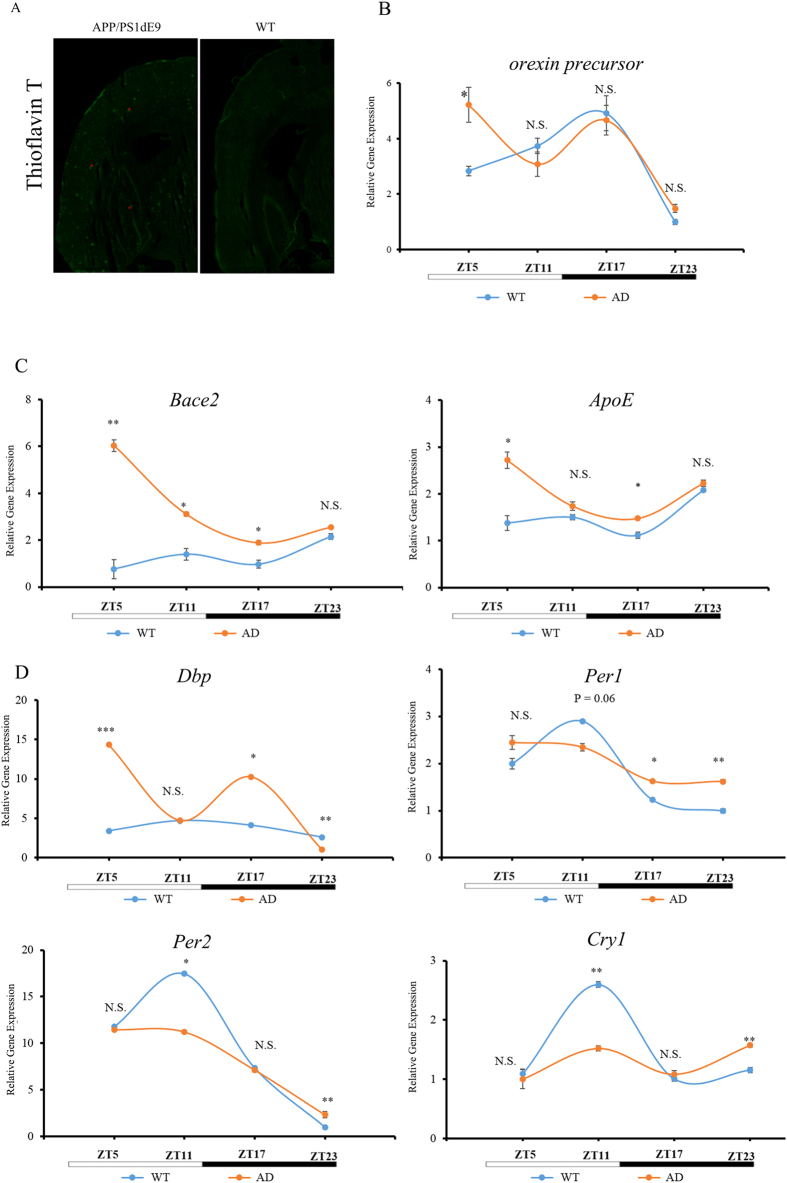
The rhythmicity of Bace2 and ApoE expression is altered in the hippocampus of APP/PS1dE9 mice.(A) Thioflavin T staining of WT and APP/PS1dE9 mice. Fibrillary amyloid plaques existed only in the brains of the APP/PS1dE9 mice (Red asterisks indicate fibrillary amyloid plaques). (B) The diurnal expression pattern of the orexin precursor gene is altered in the hypothalamus of APP/PS1dE9 mice. Expression of orexin precursor mRNA was analyzed by qPCR in the hypothalamus of WT and APP/PS1dE9 mice. The expression of this gene was higher at ZT5 in APP/PS1dE9 mice compared with aging WT mice; we did not detect any differences in mRNA levels at other time points. (C) The rhythmicity of Bace2 and ApoE expression is altered in the hippocampus of APP/PS1dE9 mice. Left panel: expression of Bace2 shows that this AD-related gene increased dramatically in the hippocampus of APP/PS1dE9 mice. Right panel: ApoE gene expression elevated the expression at ZT5, ZT11, and ZT17. The expression of this gene, which is highly correlated with the metabolism of Aβ, increased slightly in the hippocampus of APP/PS1dE9 mice. (D) Canonical E-box genes such as Dbp, Per1, Per2, and Cry1 changed the rhythmicity in the hippocampus of APP/PS1dE9 mice (n = 3–5, N.S. P > 0.05; *P < 0.05; **P < 0.01, student’s t-test). Top left panel: Dbp; Top right panel: Per1; bottom left panel: Per2; bottom right panel: Cry1.